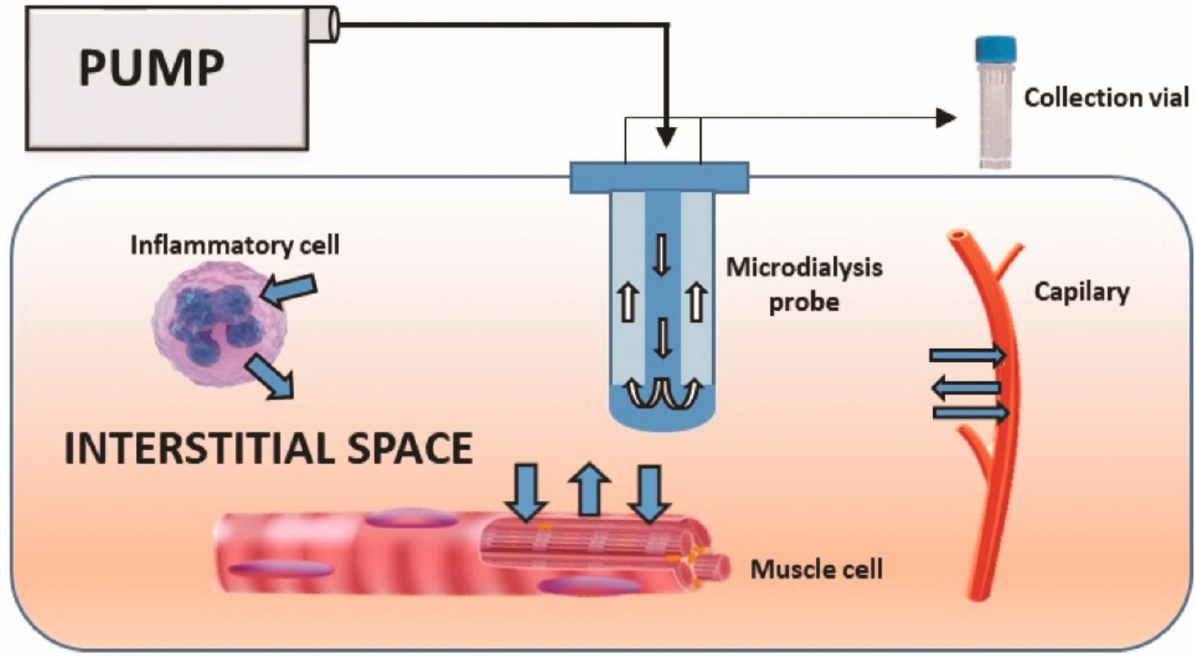
Figure 1. Schematic representation of the microdialysis system. We implemented a protocol using high cut-off membranes (100 kDa) targeting muscles with different MRI features (STIR+ and contralateral STIR-), simultaneously in the same patients (Figure 2). A summary of the characteristics of the population studied is reported in Table